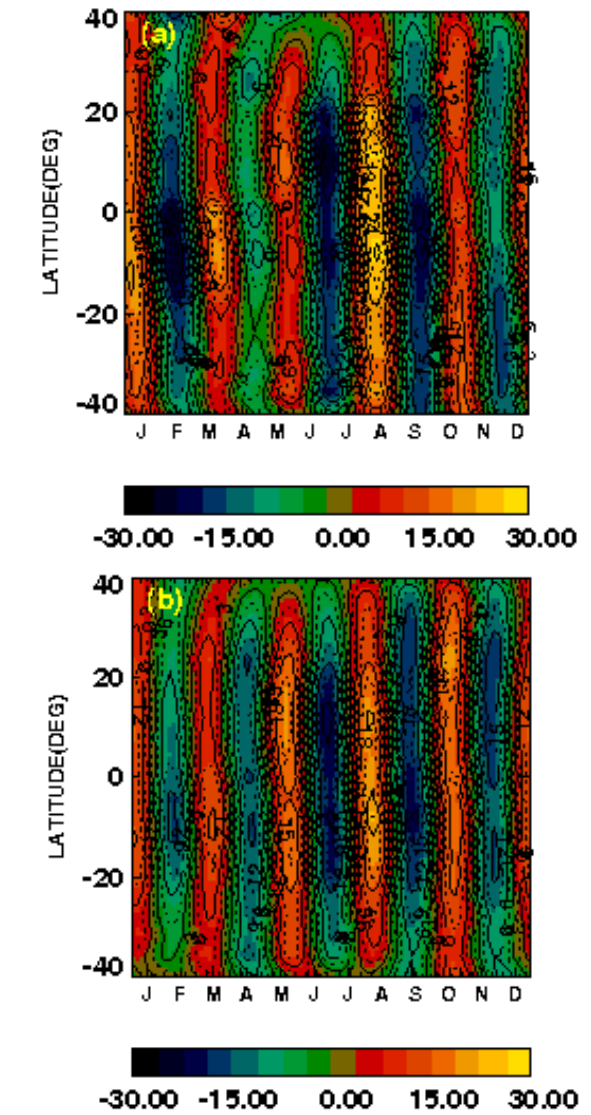
Figure 2. Synthesized results (m/s) including only wave numbers 3, 4, 5 (4 to 2.4 month periods) based on zonal mean meridional winds from HRDI at 95 km, on latitude and day-of-year coordinates: a) based on single year data (year days 92226 to 93226); b) as in a), but for data from several years merged into one 365-day period. Figure 1. Fourier amplitudes (m/s) versus wave number, derived from zonal-mean meridional HRDI winds for single year data (92226-93226) at representative latitudes and at 95 km altitude.